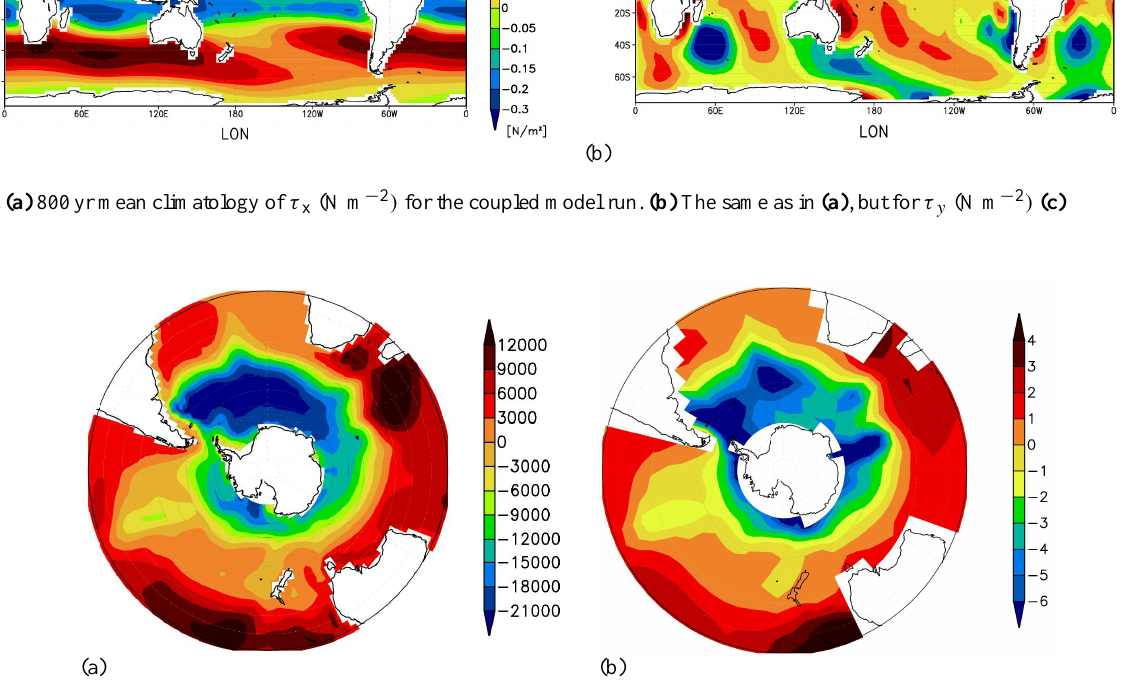
Fig. 9. (a) 800yr mean climatology of E (m 3 s − 2 ) . (b) The same as in (a) , but for SST 0 over the Southern Hemisphere